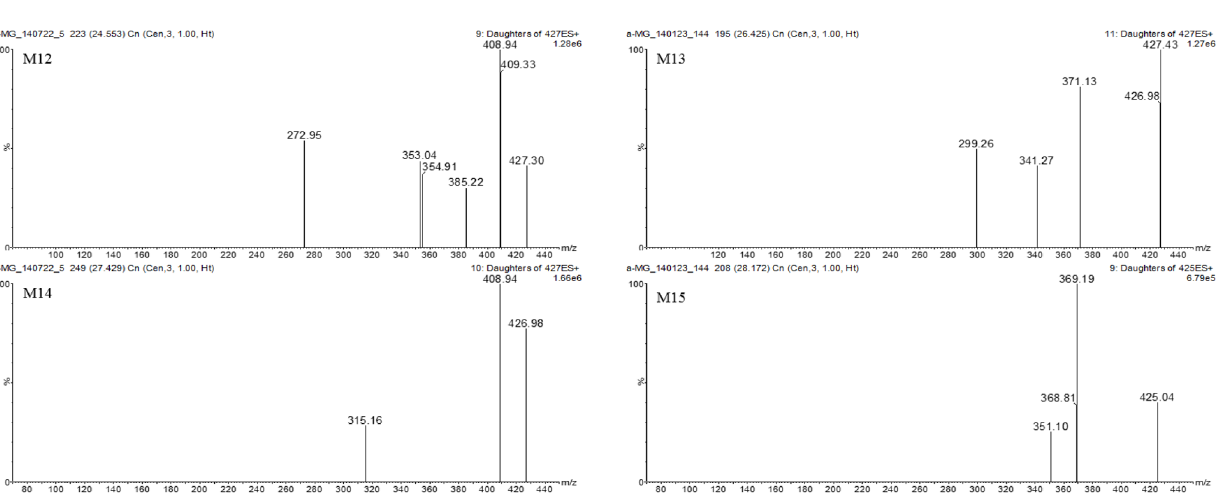
PLOS ONE | DOI:10.1371/journal.pone.0131587 July 15,